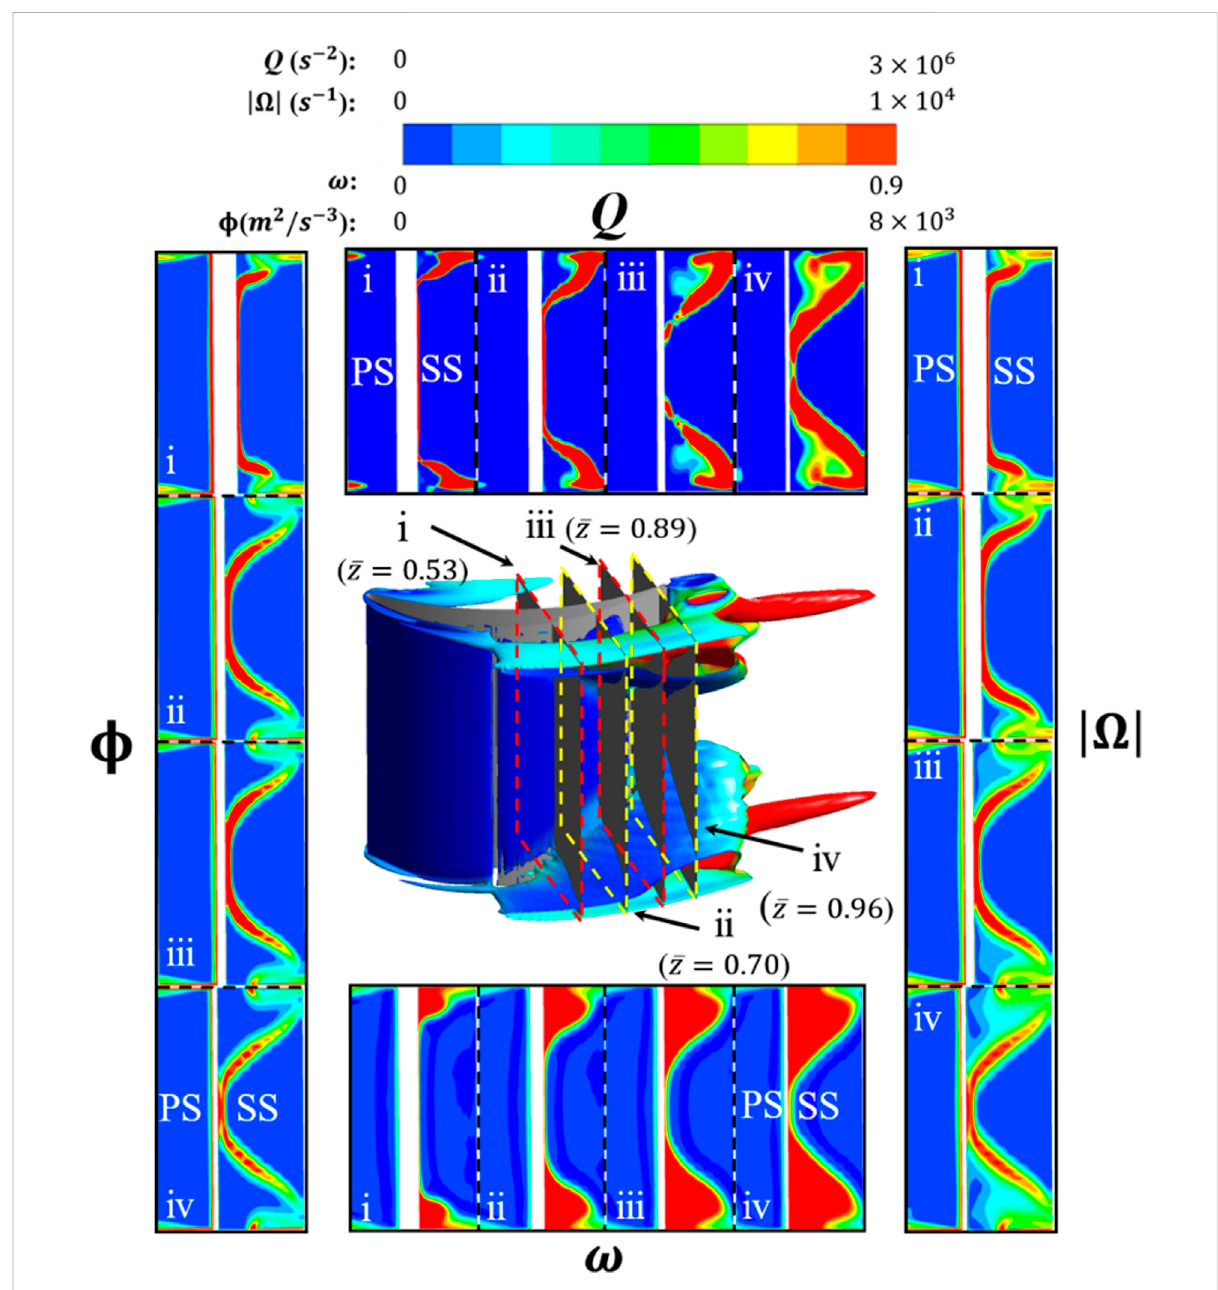
FIGURE 13 Instantaneous vortex structure and loss of stream-wise observing section in the control of